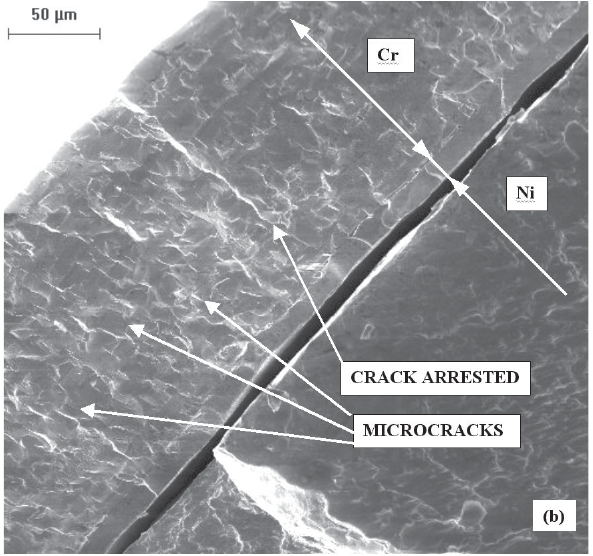
Figure 5b. Fracture surface of accelerated hard chromium (145 µ m) over electroless nickel (15 µ m) plated specimen submitted to shot peening pre treatment.